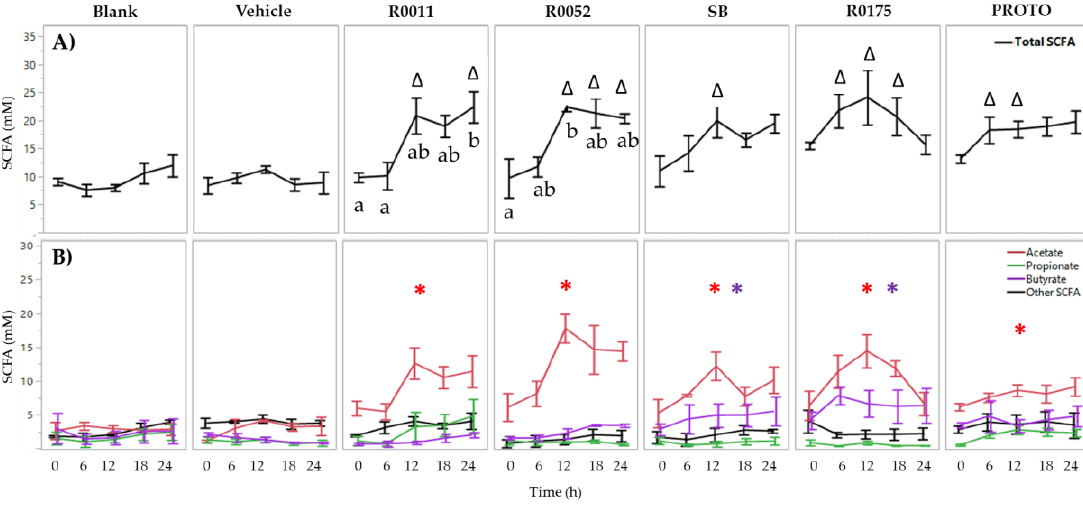
Figure 2. Short-chain fatty acid (SCFA) analysis of Clostridium (C.) difficile -infected normal fecal water. ( A ) Total SCFA quantification and ( B ) Individual SCFA quantification. Values are shown as mean ± SEM. The symbol ∆ represents significant differences ( p < 0.05) between treatment at a particular time point and blank at the corresponding time point. Means at time points within treatments without a common letter are significantly different ( p < 0.05). The symbol * in red represents significant differences in acetate production between treatment and blank ( p < 0.05) when the means of all time points are jointly considered. The symbol * in purple represents significant differences in butyrate production between treatment and blank ( p < 0.05) when the means of all time points are jointly considered. R0011 = L. rhamnosus R0011; R0052 = L. helveticus R0052; SB = S. boulardii CNCM I-1079; R0175 = B. longum R0175; PROTO = ProtecFlor TM .